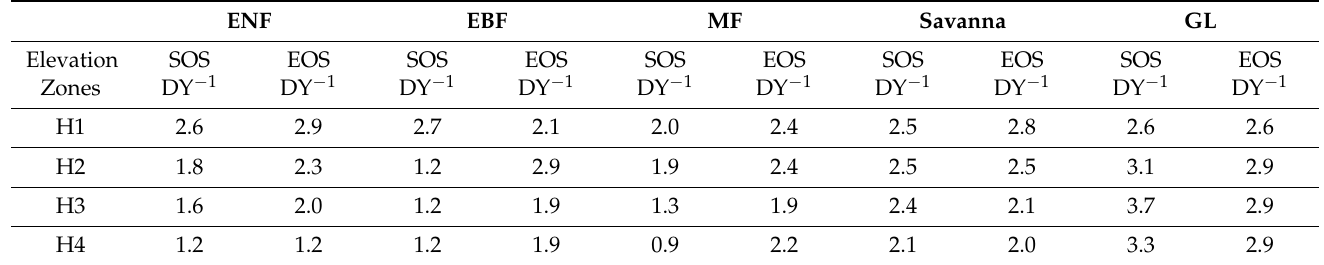
Figure 4. Interannual change trend of phenometrics (SOS and EOS) for years from 2001 to 2019 with different vegetation types. Table 2. Interannual distribution of phenometrics trend in major vegetation types.